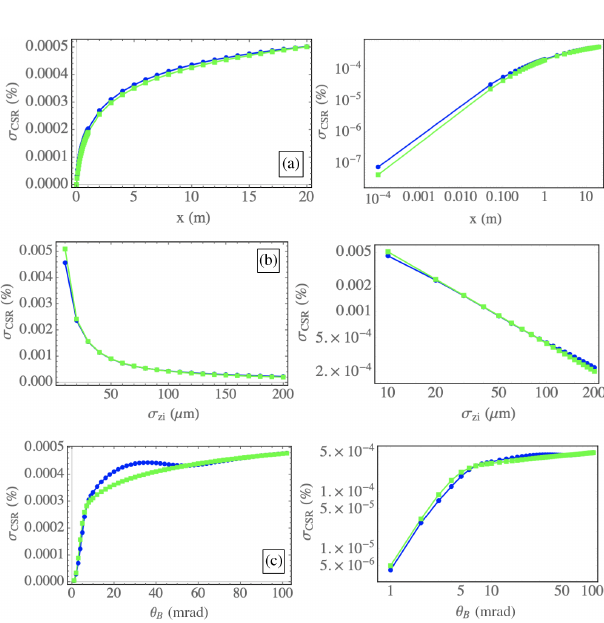
FIG. 7. The CSR rms energy spread (left column) and its Log- Log (right column) plots of an electron beam traversing the subsequent drift space, x , of a bending magnet using ELEGANT (blue marker) and Eq. (27) (green marker): (a) Varying the drift space length for a σ zi ¼ 100 μ m beam exiting a L B ¼ 0 . 55 m, θ ¼ 0 . 05 rad bending magnet. (b) Varying the incoming bunch B length, σ zi , for a L B ¼ 0 . 55 m, θ B ¼ 0 . 05 rad bending magnet and x ¼ 10 m drift space. (c) Varying the bending angle, θ B , of a L ¼ 0 . 55 m long bending magnet for a σ ¼ 100 μ m beam B zi exiting into a x ¼ 10 m drift